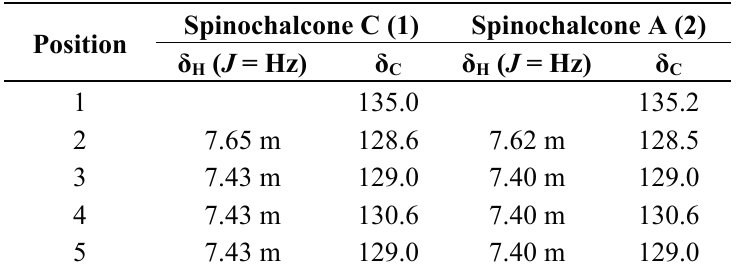
Figure 1. Chemical structures from flavonoids isolated from Aeschynomene fascicularis 1 – 4 . Table 1. NMR spectra of compounds 1 and 2